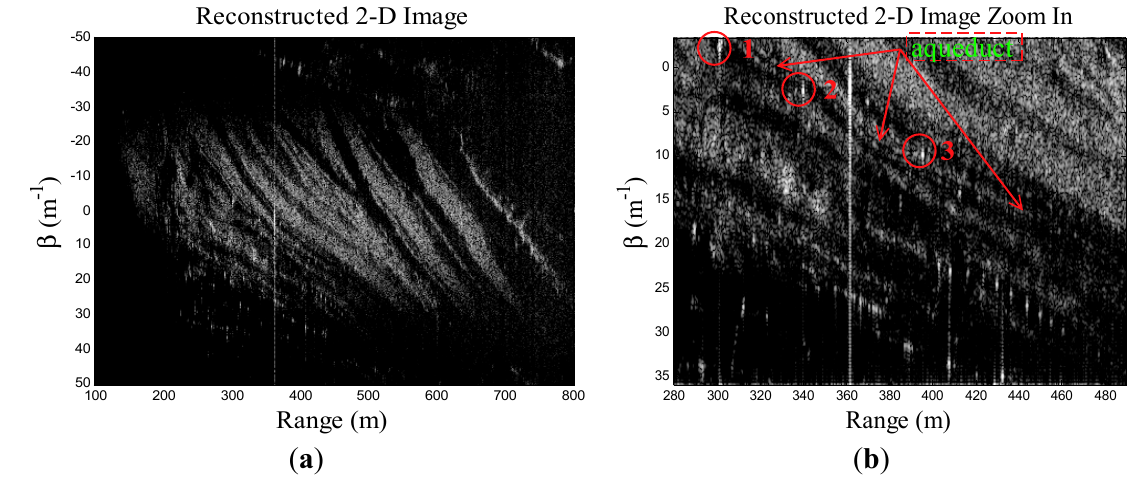
Figure 9. ( a ) Imaging result with overlapped sub-aperture processing. ( b ) Pipe line area zoom